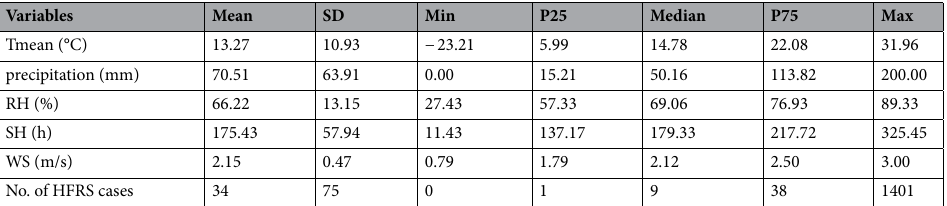
Table 1. Descriptive statistics for monthly HFRS cases and weather conditions in China, 2004–2018. SD standard deviation; min. Minimum; P25 25th percentile; P50 median; P75 75th percentile, max.